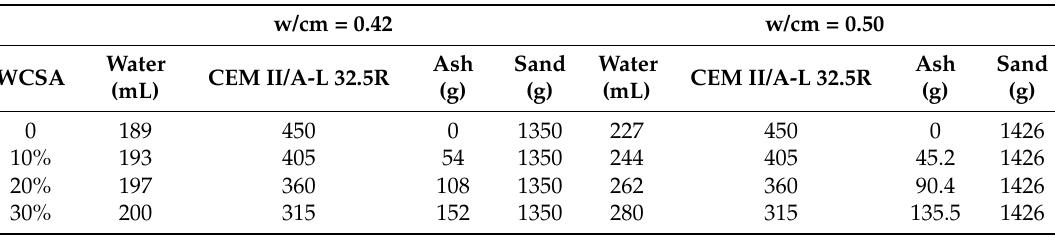
Table 3. Mixture proportions of mortars.